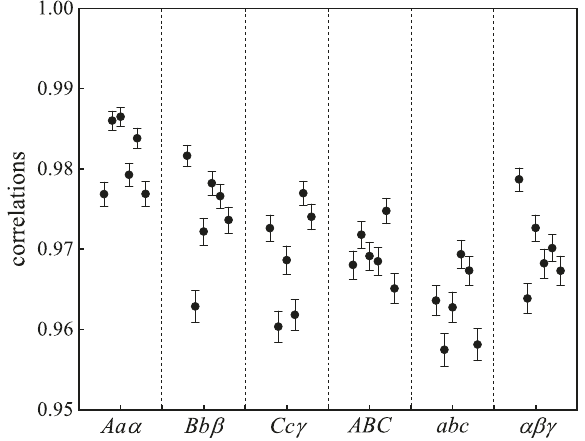
Fig. 3 Correlations within rows and columns of the Peres – Mermin square. To characterize the compatibility of different measurement, we switch the orders of the measurements. We take ψ 8 j i ¼ ð 1 j i þ ffiffiffi p 2 j iÞ = 2 as an example. We show the measured absolute values of the ensemble average of the products of observables for six possible permutations within rows and columns of the Peres – Mermin square, which fall within the range from 0.957(2) to 0.986(1) and agree with theoretical prediction 1. We fi nd that all values for the non- contextual inequality fall within the range from 5.786(5) to 5.868(4). Even with experimental imperfections, the experimental violation of the non-contextual inequality still agrees with the quantum- mechanical